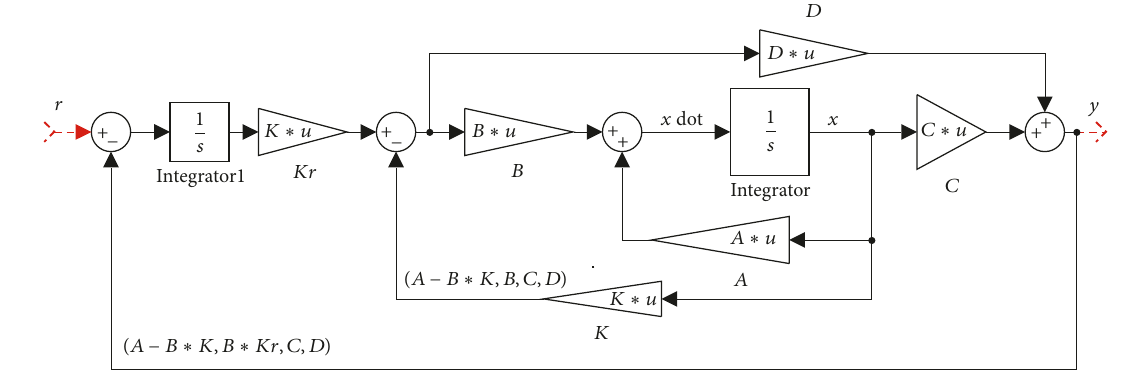
Figure 16: Block diagram of a system with state feedback and integral control using MATLAB Simulink.